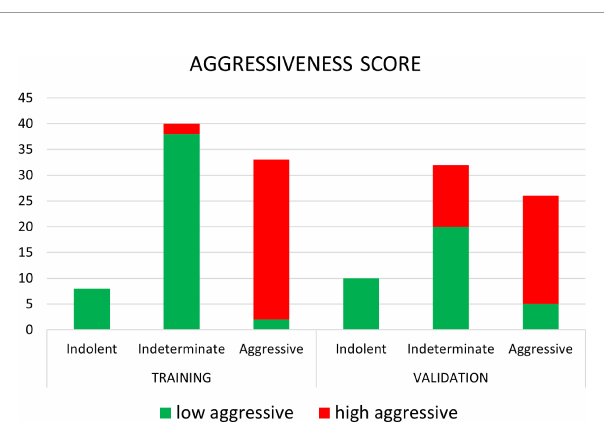
FIGURE 7 | Distribution of low aggressive and high aggressive tumors in the three levels of aggressiveness score, for both the training and validation